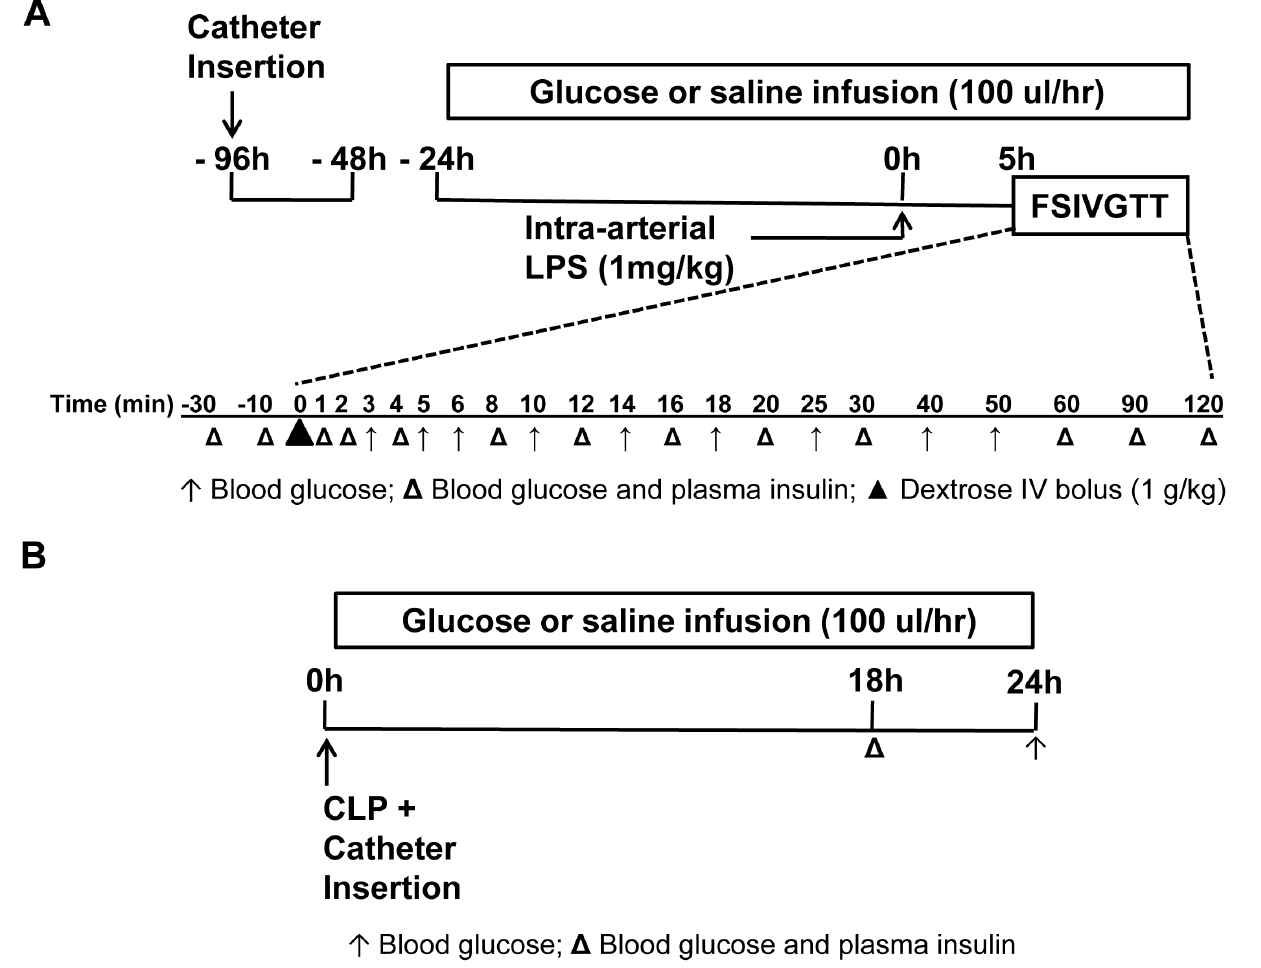
Figure 1. Experimental timelines. (A) Chronically catheterized mice (femoral artery and vein) were given three days to recover from surgery and infused intravenously (iv) with either saline or glucose for 24 hours prior to intra-arterial administration of either lipopolysaccharide (LPS; 1 mg/kg) or vehicle. Five hours after LPS or vehicle administration a frequently sampled intravenous glucose tolerance test (FSIVGTT) was performed over a two hour period. An iv glucose bolus of 1 g/kg D50 was given over approximately 15 sec (▲). Subsequently, multiple samples of either blood glucose and plasma insulin (Δ) or glucose alone (↑) were taken from the arterial catheter at the times identified. Red blood cells were spun down and re-infused into the mouse throughout the protocol to avoid anemia. (B) Mice underwent cecal ligation and puncture (CLP) immediately after chronic catheterization of the femoral artery and vein. Animals were infused intravenously with either saline or glucose upon completion of surgery and followed for 24 hrs. Blood glucose and plasma insulin (Δ) or blood glucose alone (↑) were sampled from the arterial catheter at the times